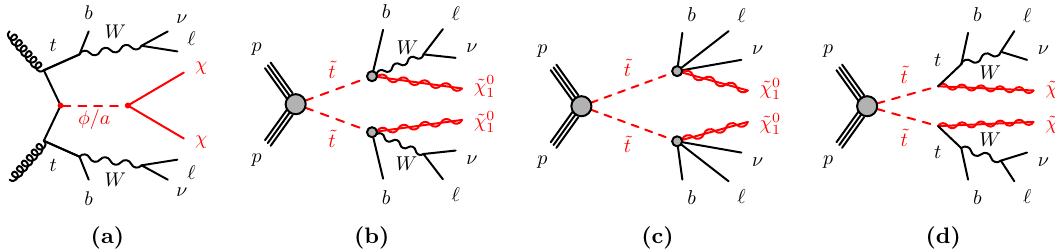
Figure 1 . Diagrams representing the signal models targeted by the searches: (a) the spin-0 me- diator models, where the mediator decays into a pair of dark-matter particles and is produced in association with a pair of top quarks ( pp → χ ¯ χt ¯ t ), (b) the three-body ˜ t on-shell W boson, a b -quark and the lightest neutralino ( ˜ t 0 ¯ ‘ and ν are a anti-lepton with its neutrino and (d) the two-body ˜ t mode ( ˜ t → b ¯ ‘ν ˜ χ 1 ) where 1 into an on-shell top quark and the lightest neutralino ( ˜ t distinction between particle and anti-particle is